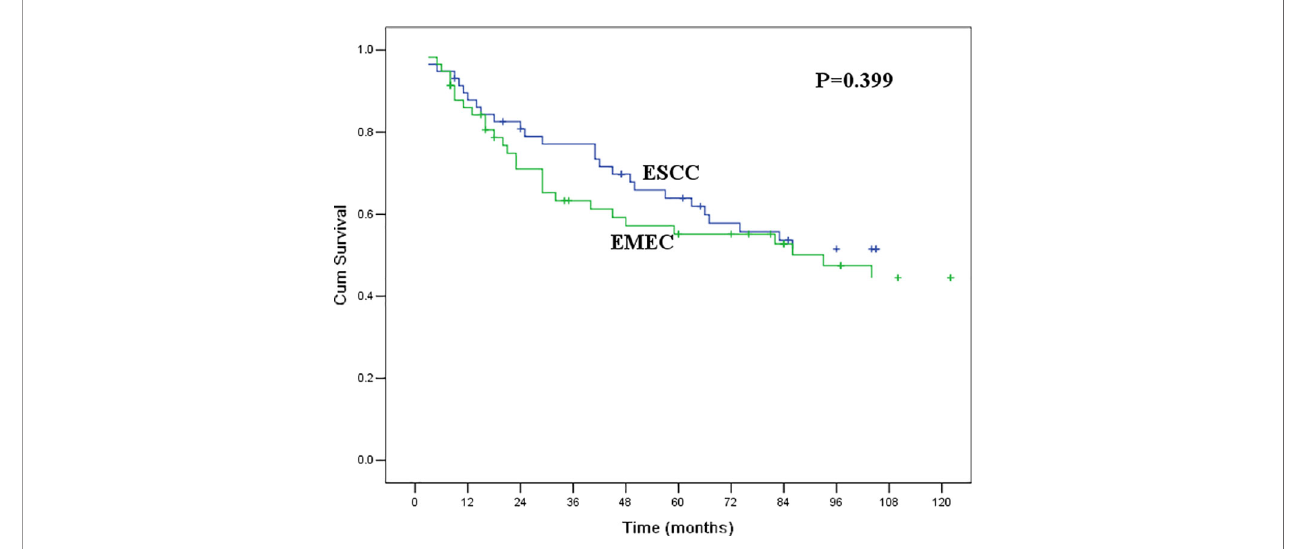
FIGURE 2 | Kaplan-Meier curves for overall survival between patients with ESCC and EMEC. The survival difference was not signi fi cant